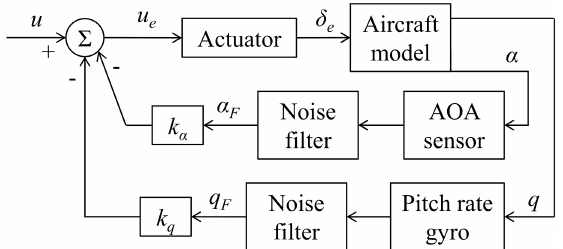
Figure 1. Longitudinal stability augmentation system. The characteristics of the oscillation frequency and damping of the short period modal are modified by feeding back the angle of attack and pitch rate to the